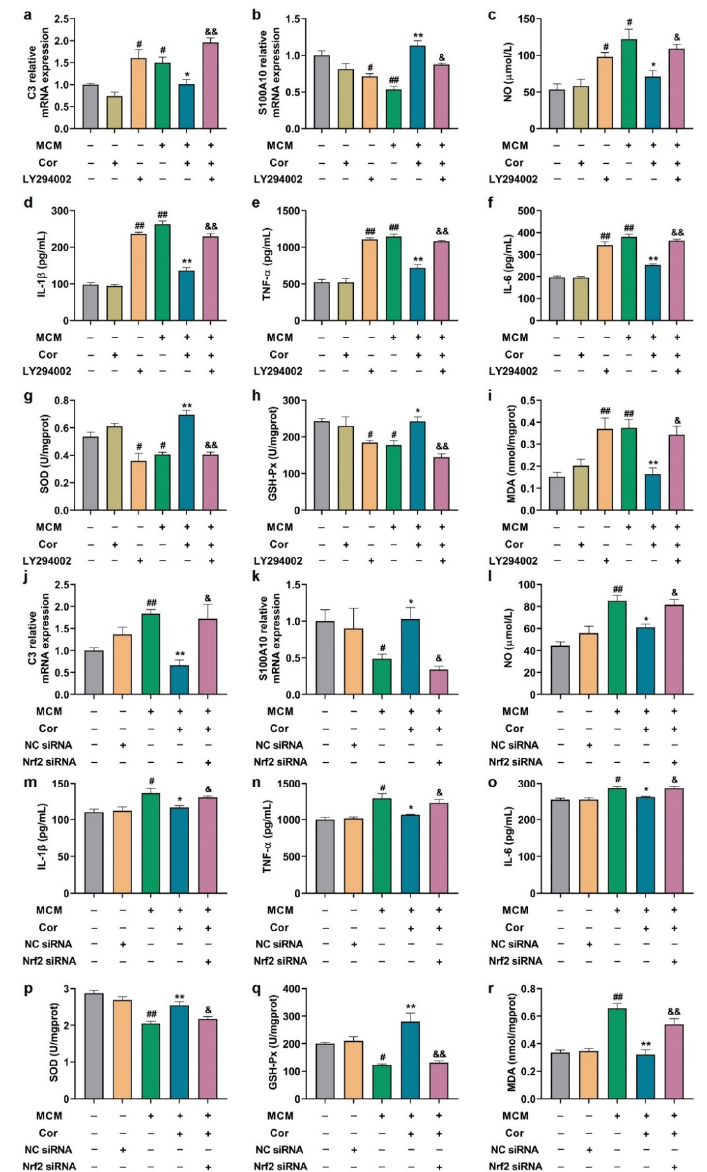
Figure 10. The AKT/Nrf2/NF- κ B axis was associated with cornuside-elicited A1/A2 and antioxidase expression and action against neuroinflammation in C6 cells. ( a – i ) C6 cells pretreated with